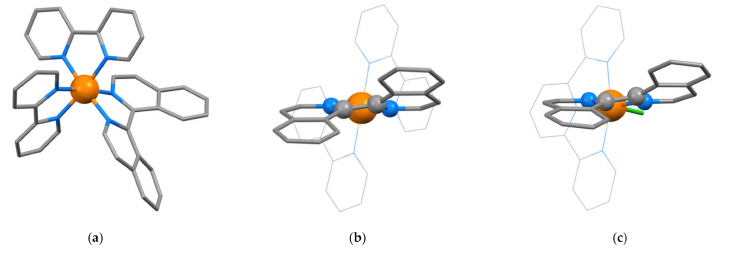
Figure 11. ( a ) The structure of the ( Λ )-[Ru{(1 M )-(biiq)}(bpy) 2 ] 2+ cation found in rac -( ∆ )-[Ru{(1 P )- (biiq)}(bpy) 2 ](PF 6 ) 2 with hydrogen atoms omitted for clarity The lattice also contains the enantiomeric ( ∆ )-[Ru{(1 P )-(biiq)}(bpy) 2 ] 2+ cation; ( b ) a projection of the ( Λ )-[Ru{(1 M )-(biiq)}(bpy) 2 ] 2+ cation in the N–Ru–N showing the positioning of C1 and C1 (cid:48) above and below this plane. The bpy ligands are rendered as wireframe, the biiq as capped sticks and the five atoms defining the chirality of the chelate ring as balls, and all hydrogen atoms have been omitted for clarity; ( c ) the [Os{(1 M )-biiq}Cl(tpy)] + cation present in single crytsals obtained from rac-([Os{(1 MP )-biiq}Cl(tpy)]Cl · H 2 O; the compound crystallized in homochiral crystals (all 1 M or all 1 P ) in the space group P 2 1 2 1 2 1 . The tpy ligand is rendered as wireframe, the biiq as capped sticks and the five atoms defining the chirality of the chelate ring as balls and all hydrogen atoms have been omitted for